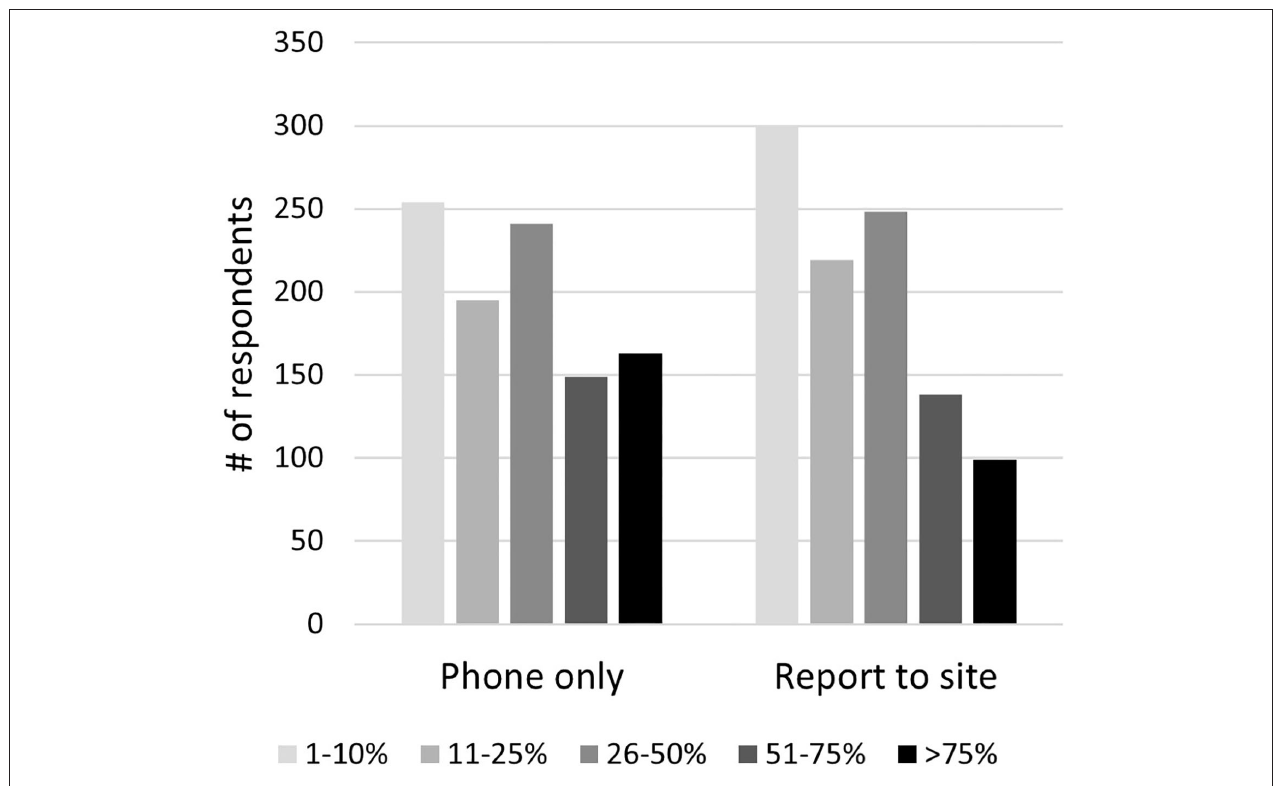
FIGURE 5 | Anxiety levels experiences while on-call, as reported by male and female practice owners and associate veterinarians.